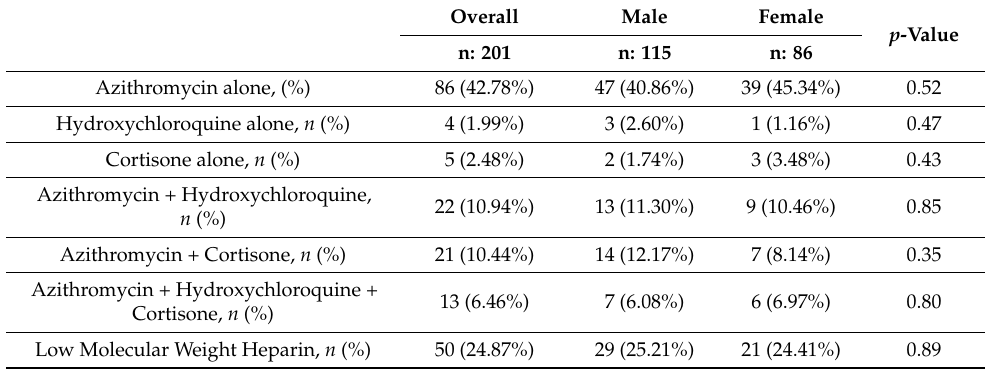
Table 3. Pharmacological experimental drugs for COVID-19 among treated outpatients.